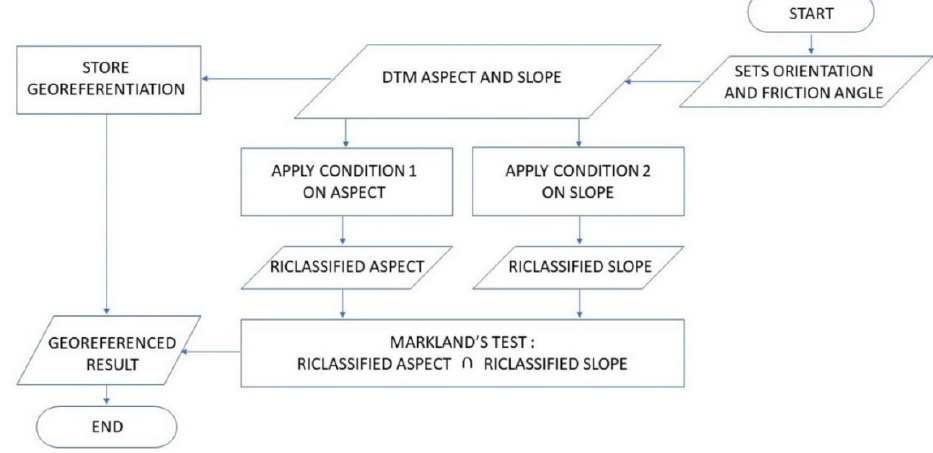
Figure 1. Diagram describing the general workflow the tool employs to perform its function.